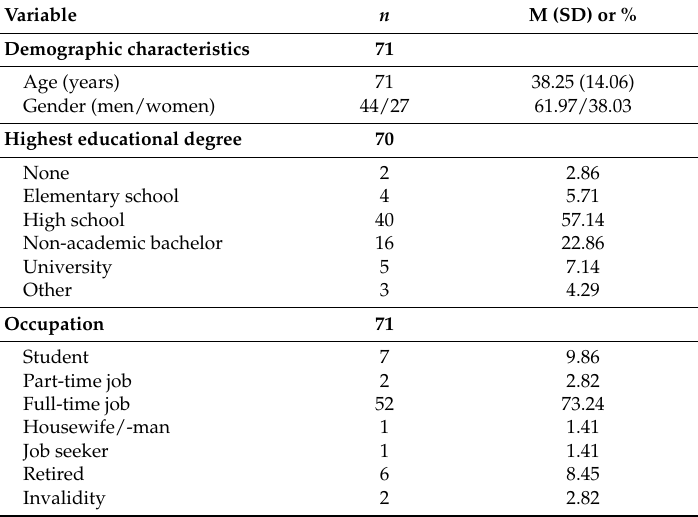
Table 1. Sociodemographic characteristics of included